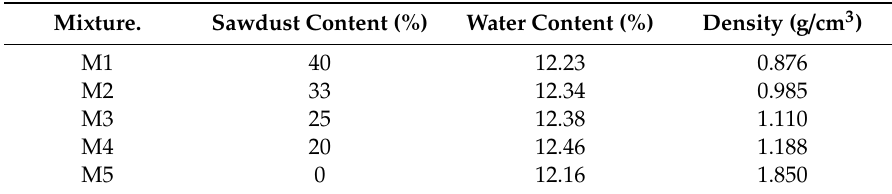
Figure 2. The metal mold for the construction of the specimens.